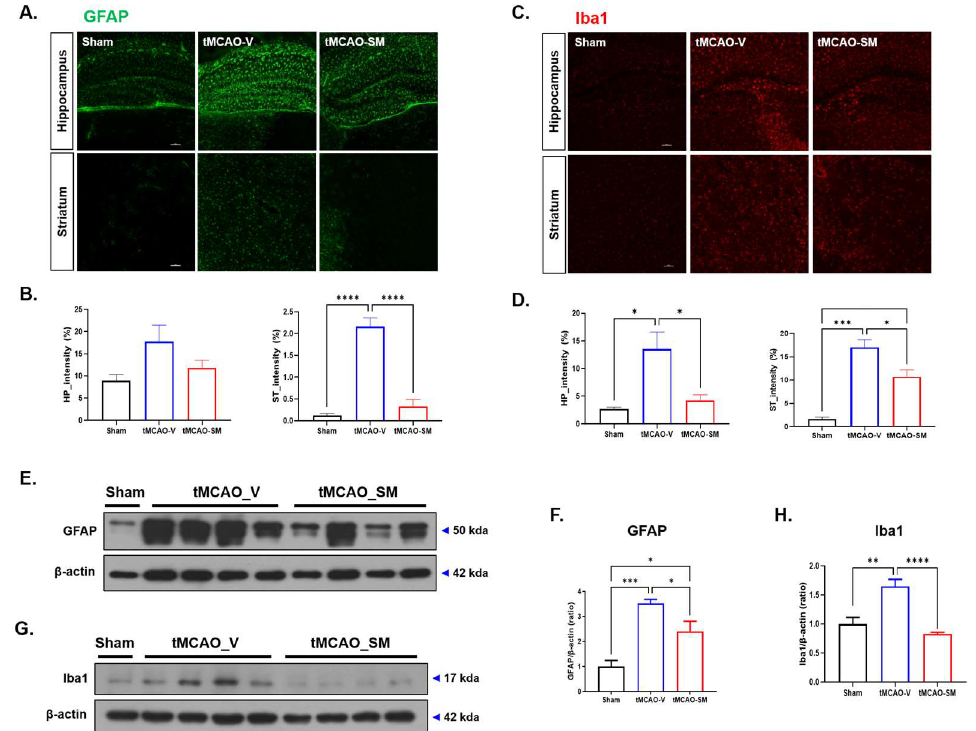
Figure 2. SM alleviates gliosis in tMCAO mouse brain. ( A ) Representative image of GFAP staining in hippocampus and striatum. ( B ) Quantification of interest of GFAP immunofluorescence in hip- pocampus and striatum. Scale bars, 100 µm. (Sham, n = 3; tMCAO-V, n = 6; tMCAO-SM, n = 7) ( C ) Representative image of Iba1 staining in hippocampus and striatum. ( D ) Quantification of interest of Iba-1 immunofluorescence in hippocampus and striatum. (Sham, n = 3; tMCAO-V, n = 4; tMCAO- SM, n = 4). ( E ) Western blot to confirm GFAP expression level in penumbra area including cortex and striatum. ( F ) Quantification of GFAP level in Western blot. ( G ) Western blot to confirm Iba1 expression level in penumbra area including cortex and striatum. ( H ) Quantification of Iba1 level in Western blot. β-actin is a loading control. Values are expressed as mean ± SEM (Sham, n = 4; tMCAO- V, n = 6; tMCAO-SM, n = 6). Statistical analysis between the three groups was performed using the one-way ANOVA followed by Tukey’s multiple comparisons test. * p < 0.05, ** p < 0.01, *** p < 0.001, and **** p < 0.0001.